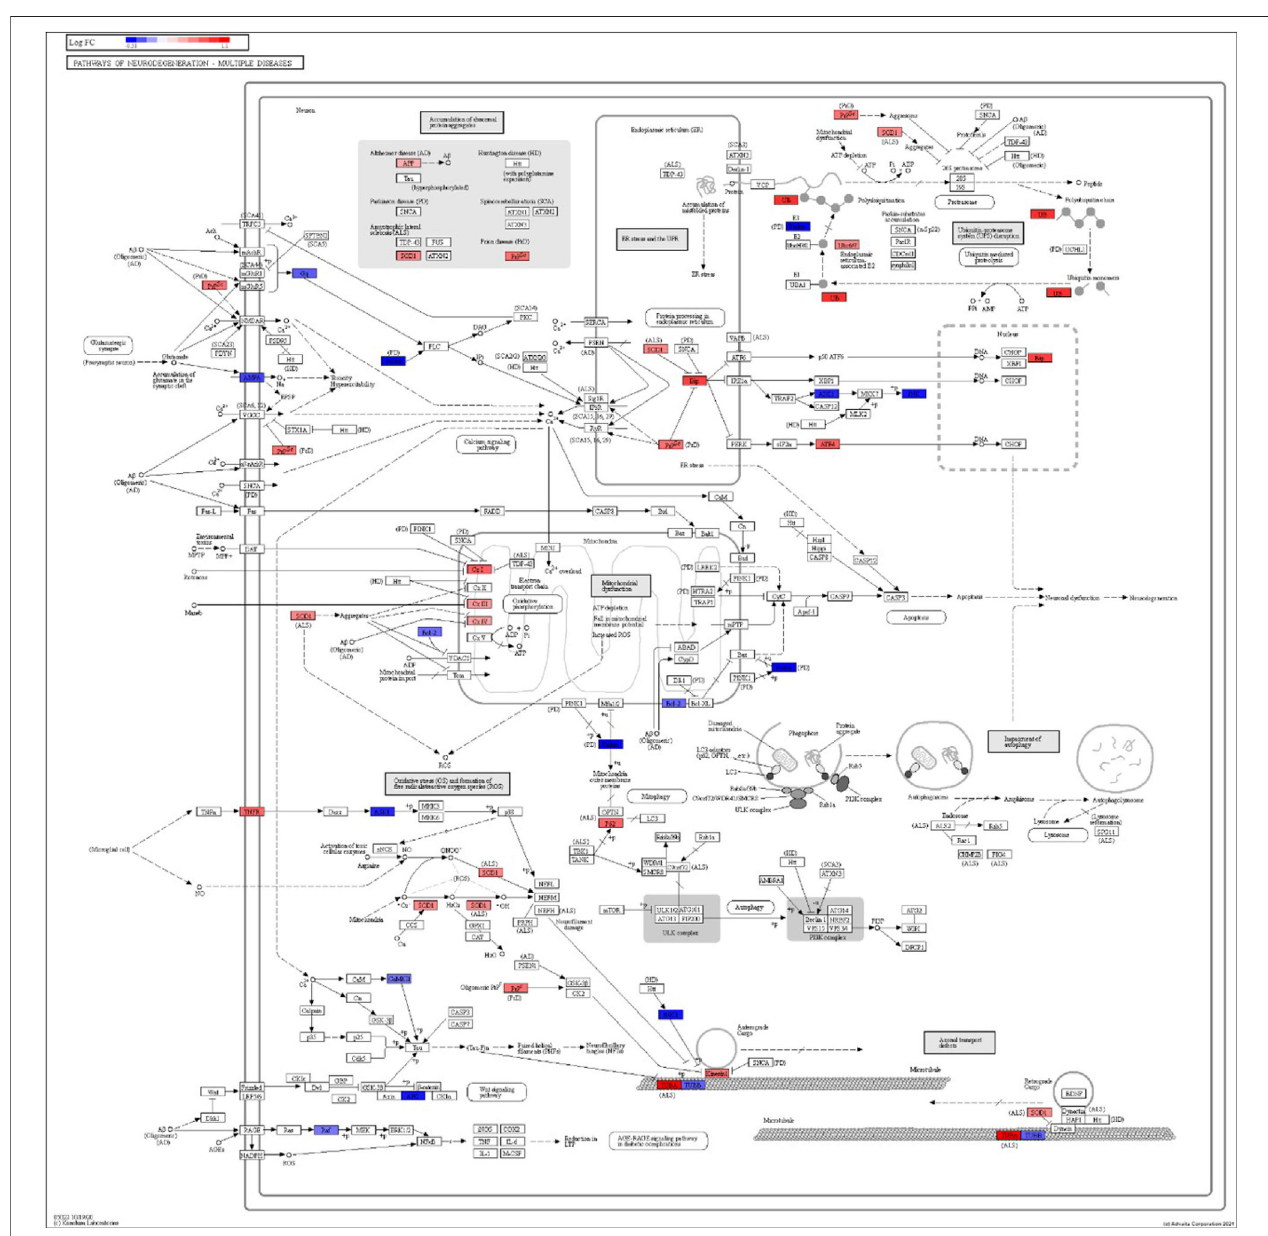
FIGURE 6 | iPathwayGuide analysis shows the differentially regulated genes in the KEGG neurodegeneration pathway (multiple diseases) in the astrocytes of the AD group (AD00203) compared to the astrocytes of the healthy control group (AD00201).